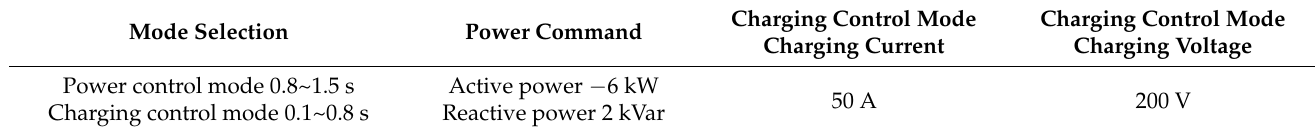
Table 2. Power compensator simulation parameters.